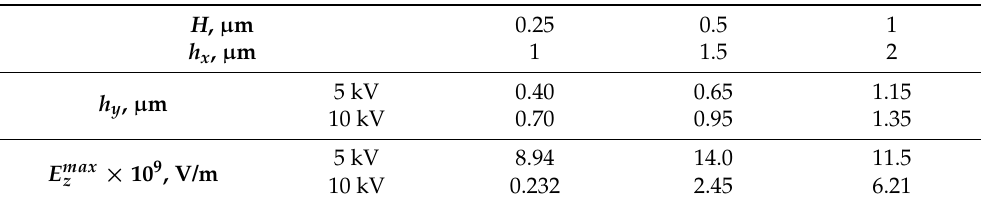
Table 2. h y and E max z values corresponding to the beginning of the joining of 0.3 E max z -zones at Scheme B and D = 5000 µ C/cm 2